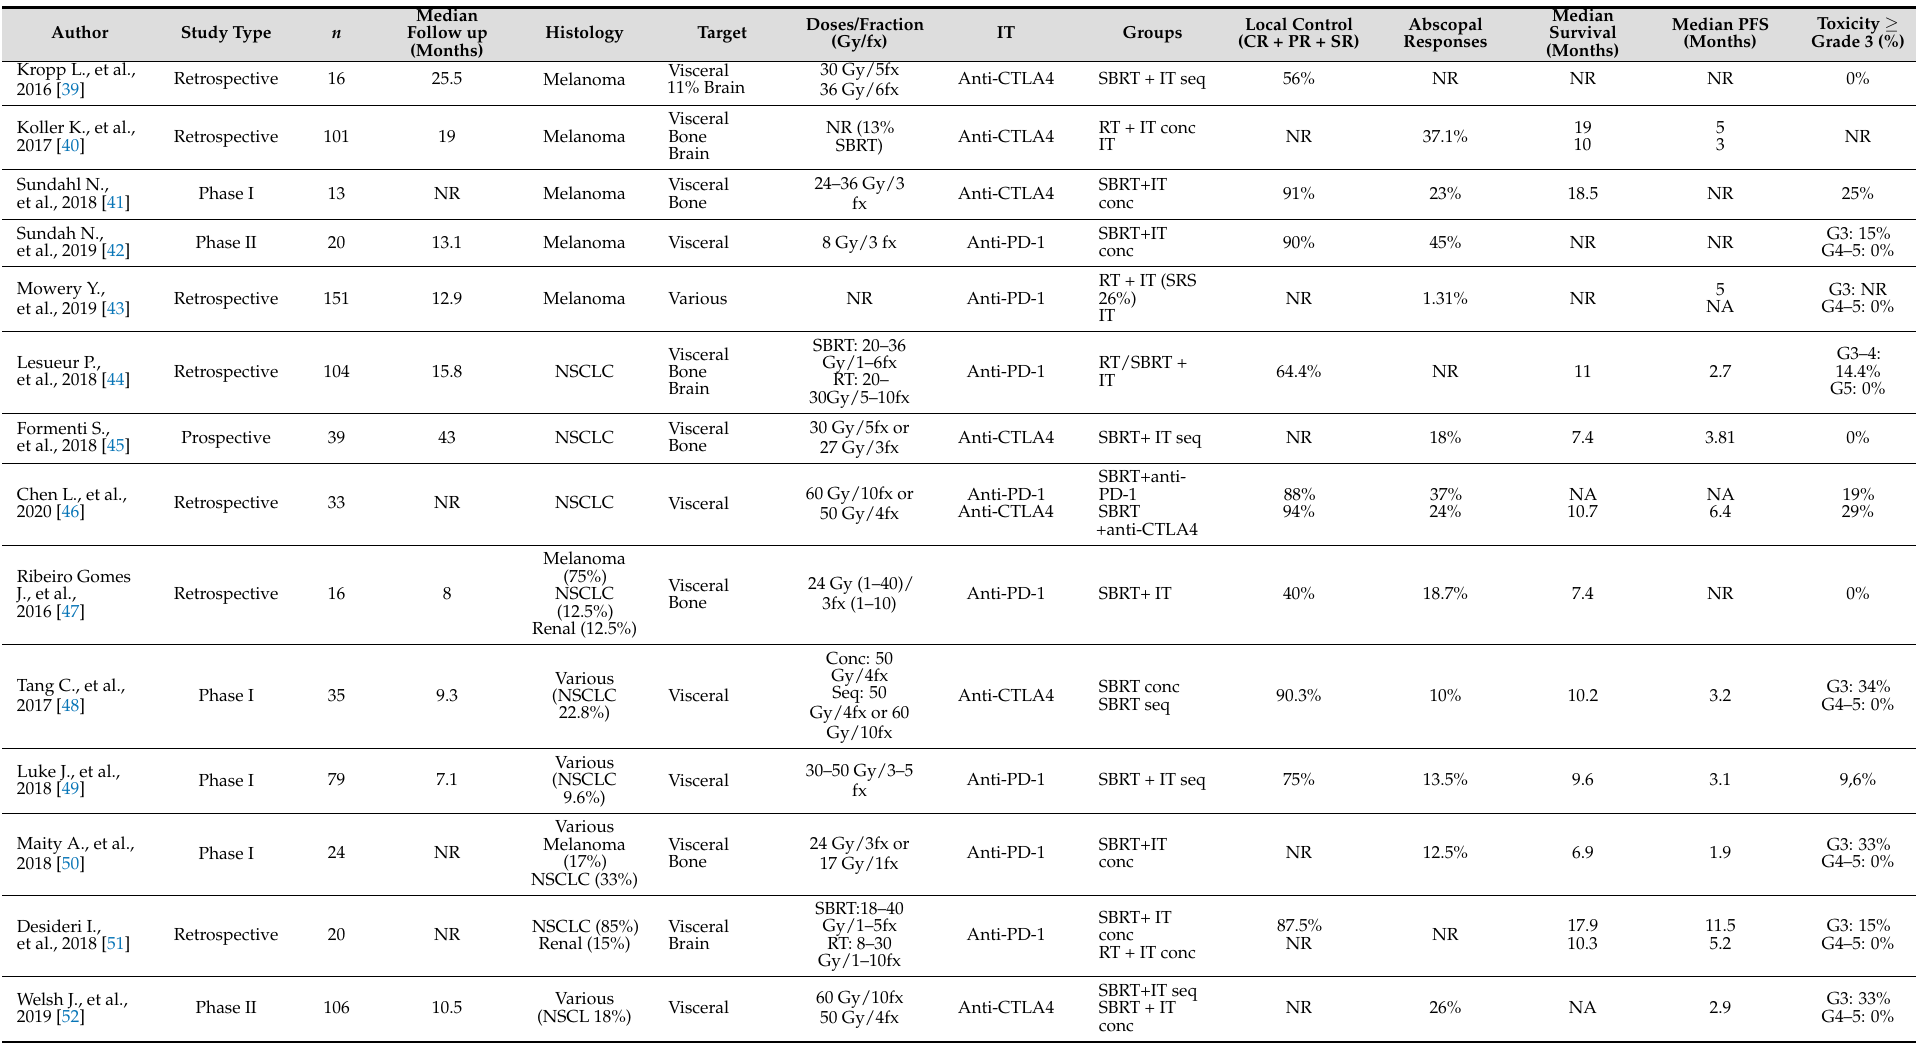
Table 2. Results of the ICI + SRS combination in extracerebral metastases in melanoma/non-small-cell lung cancer ( n =